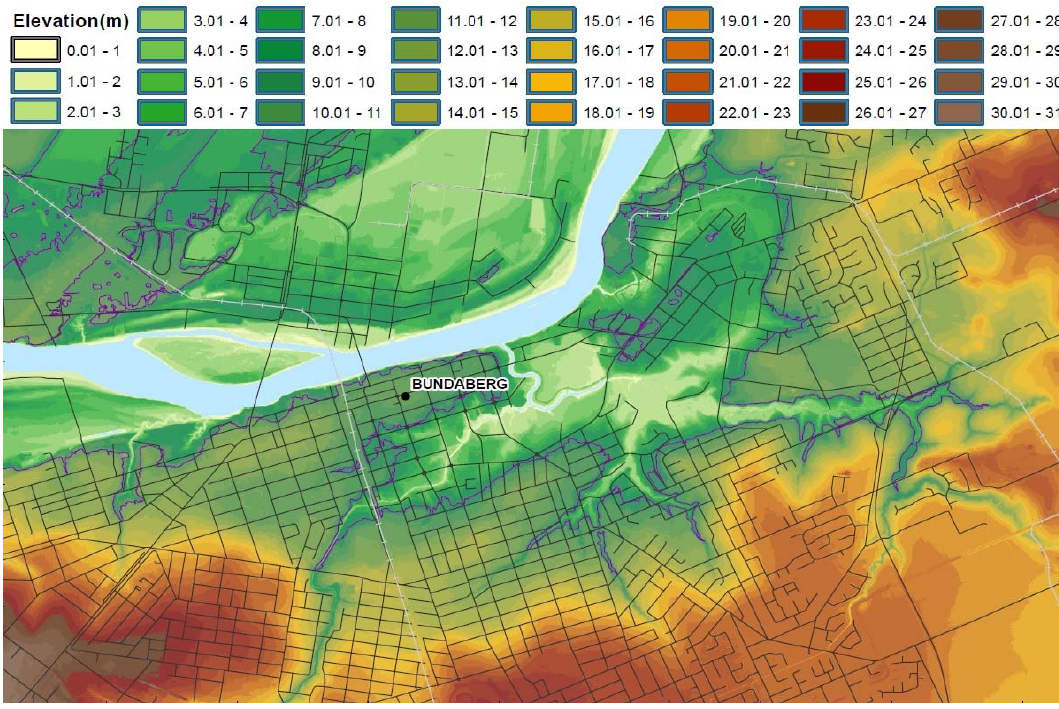
Figure 2. Bundaberg ground elevation [46]. Water 2016 , 8 , 282